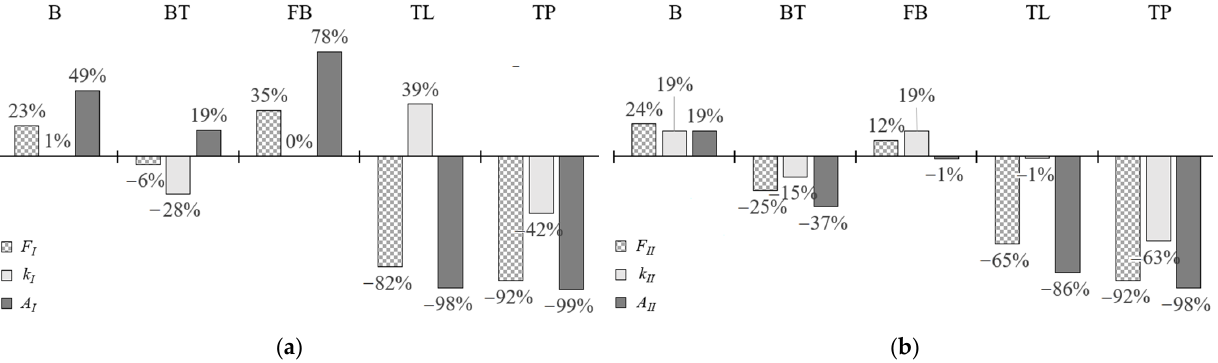
Figure 18. Change of the resistance ( F i ), stiffness ( k i ), and strain energy capacity ( A i ) concerning the self ‐ drilling fasteners (F): ( a ) linear stage, ( b ) non ‐ linear stage.